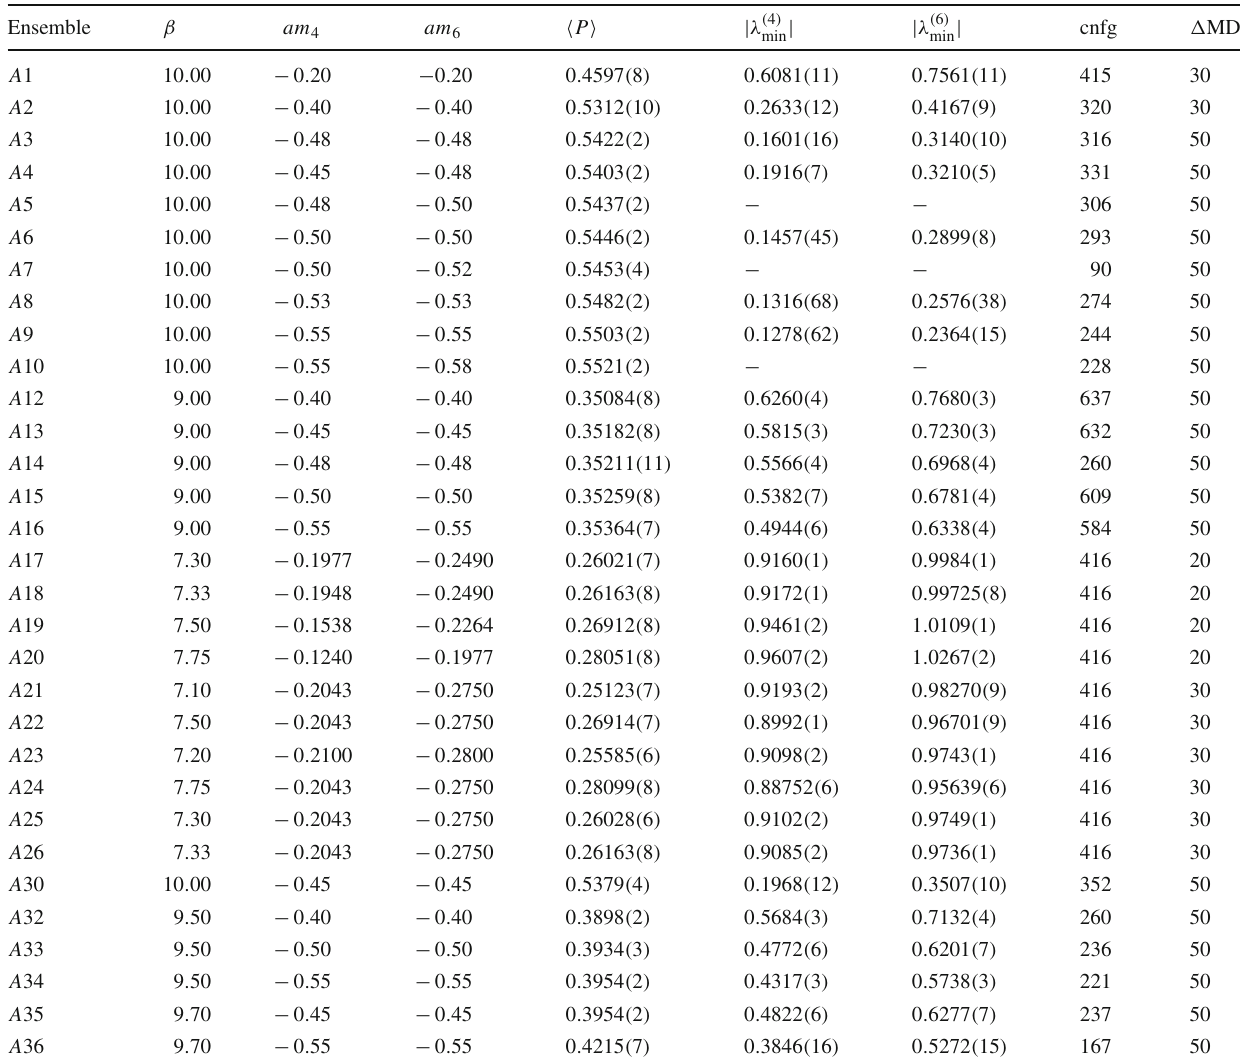
Table 3 Table run, volume ( 8 3 × 16 ) a 4 , plaquette gauge action